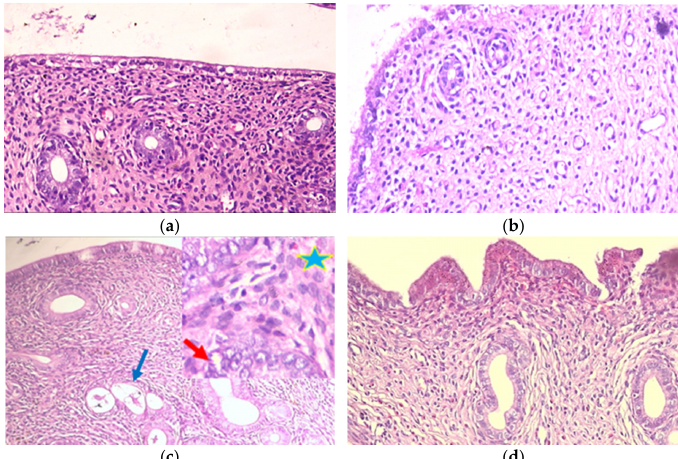
Figure 1. Effect of irbesartan (IRB) on histopathological changes in estradiol benzoate-induced endometrial hyperplasia (EH) and atypia in rats (hematoxylin and eosin, × 200; ( n = 7/group). ( a , b ) Control and IRB groups, respectively, reveal no histopathological abnormalities. ( c ) In the EH group, the epithelial lining shows hypertrophy and stratification (blue arrow). The insert ( × 400) shows vesicular nuclei exhibiting atypical features with loss of polarity, anisonucleosis, and promi- nent nucleoli (red arrow), and the stomas show excessive leukocytic infiltration (asteroid). ( d ) The EH+IRB group shows a picture suggestive of almost normal-looking disordered endometrial glands, and the lining epithelium was low